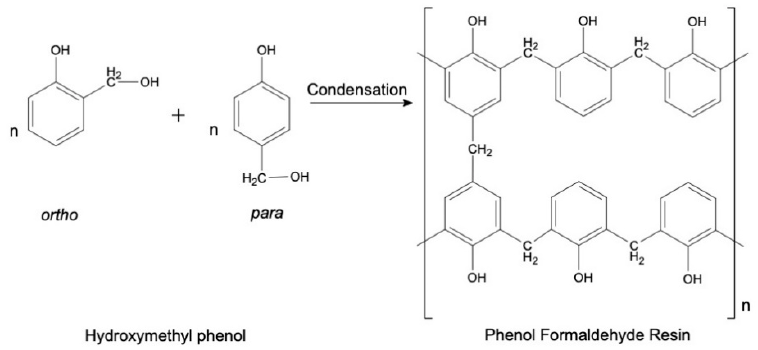
Figure 3. Condensation reaction of hydroxymethyl phenol [12].